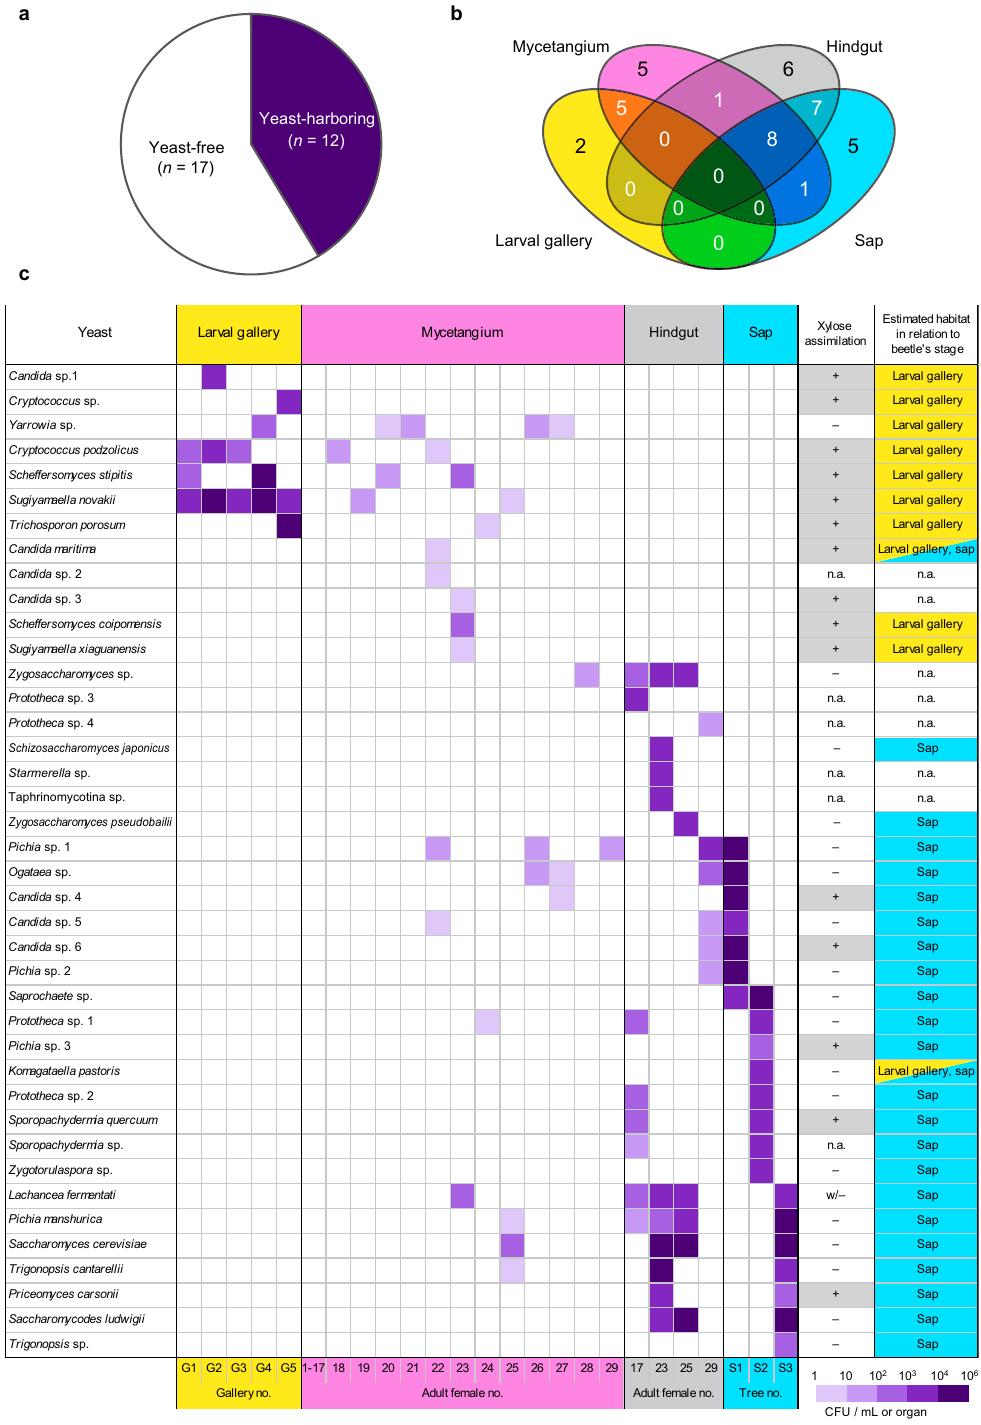
Figure 2. Yeasts isolated from Aegus subnitidus -associated materials. ( a ) Proportions of yeast-harboring and free females. ( b ) Number of yeast species isolated from each of the isolation sources. c Yeasts isolated from larval galleries (G1–G5), mycetangia (1–29), hindguts (17, 23, 25, and 29), and fermented sap of Quercus glauca (S1), Q. serrata (S2), and Q. variabilis (S3). Xylose assimilating ability of each yeast is indicated as follows: +, positive; −, negative; w/−, weakly positive or negative. n.a. not